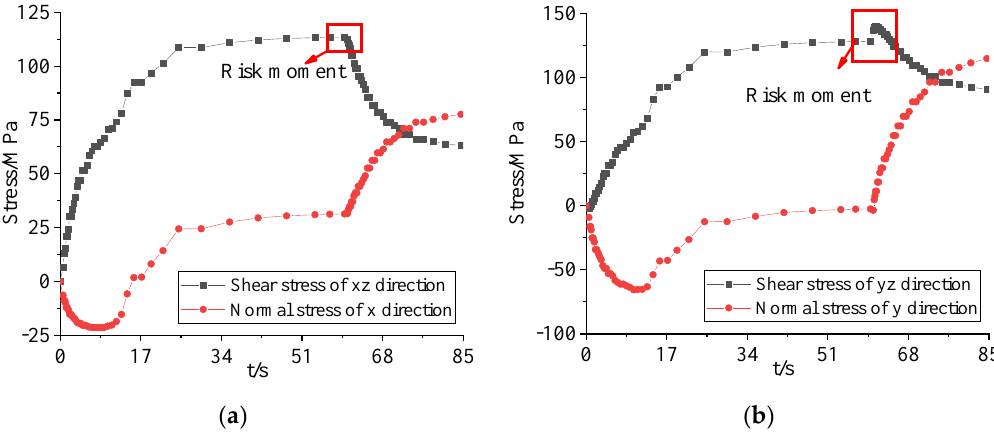
Figure 17. Stress curves in the slave model. ( a ) TC layer at the leading edge; ( b ) TC layer at the trailing edge.